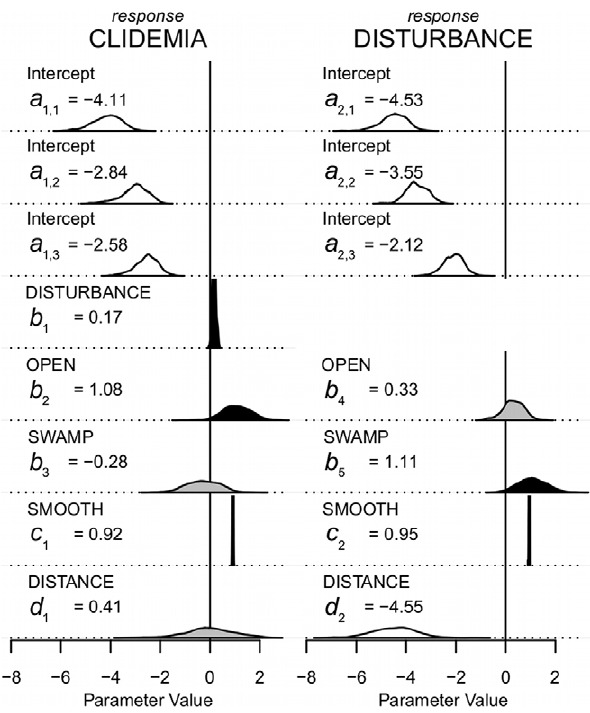
Figure 4. Posterior distributions of parameter values for Clidemia hirta abundance (left) and soil disturbance (right). Colors were assigned based on the 95% credible interval: Black , 0; Grey, incorporating zero; White . 0. The median values are given beside each distribution. The x-axis represents the parameter value and the y- axis the probability (some peaks are truncated).